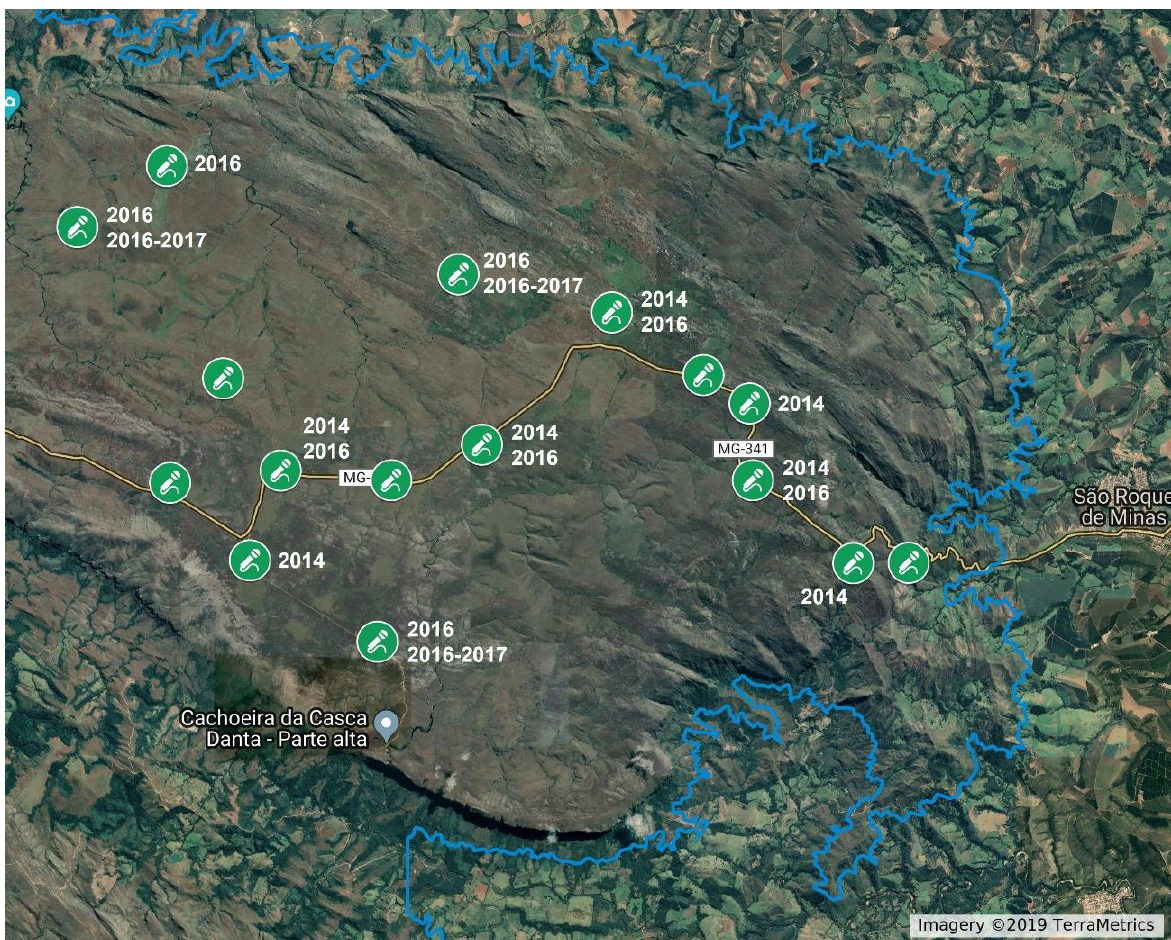
Figure 1. The location of acoustic recorders at Serra da Canastra National Park in Minas Gerais state, Brazil. Microphone symbols indicate the position of the autonomous recorders (Wildlife Acoustics SongMeters SM2+). Recorders with no noted years were active in 2014 (April–July), 2016 (March– June) and 2016–2017 (December–January) periods. The blue line indicates the park boundaries. Image from Google Earth © 2019 TerraMetrics.